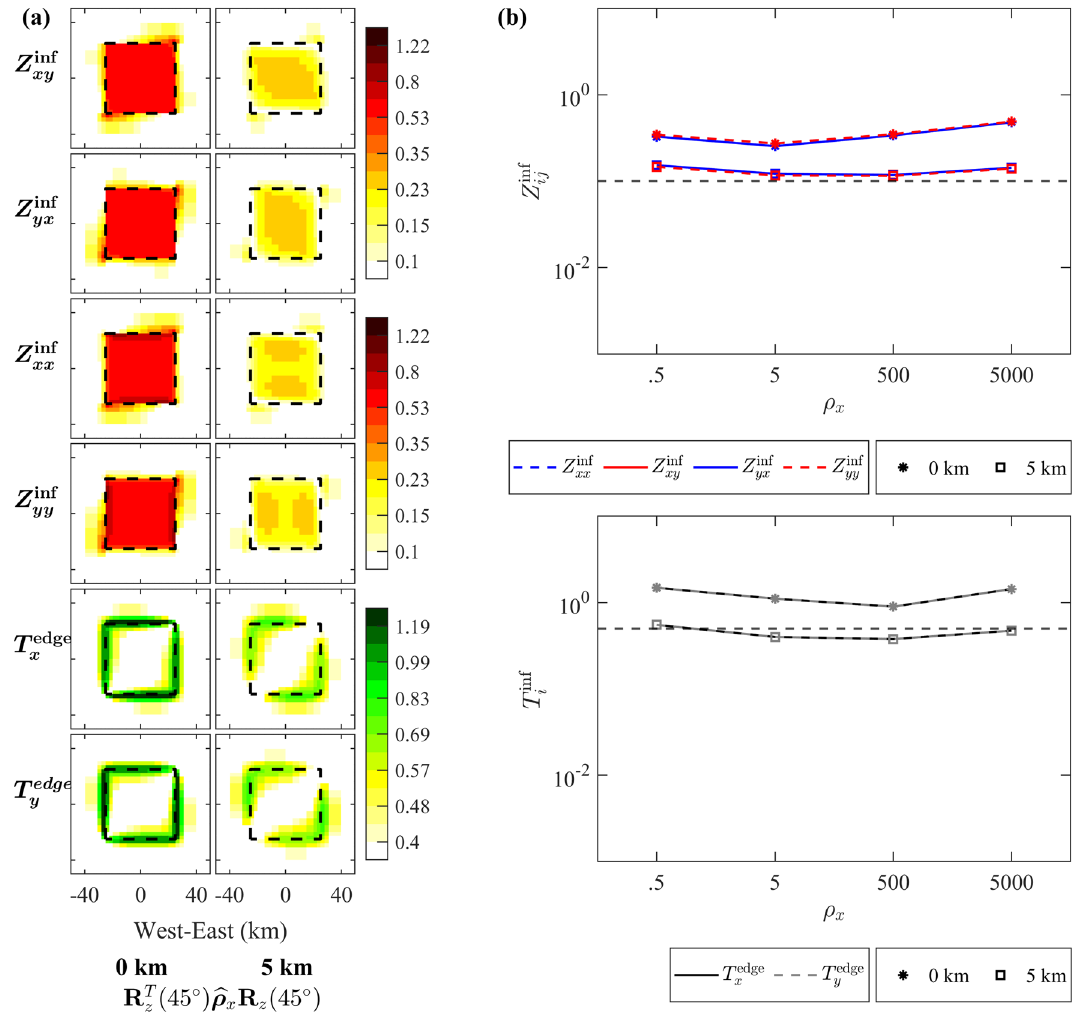
500 0 0 0 50 0 ρ x =  . b Logarithmic plots of Z inf xx , Z inf yy , Z inf xy , Z inf yx , T edge x , and T edge y with  0 0 50   �